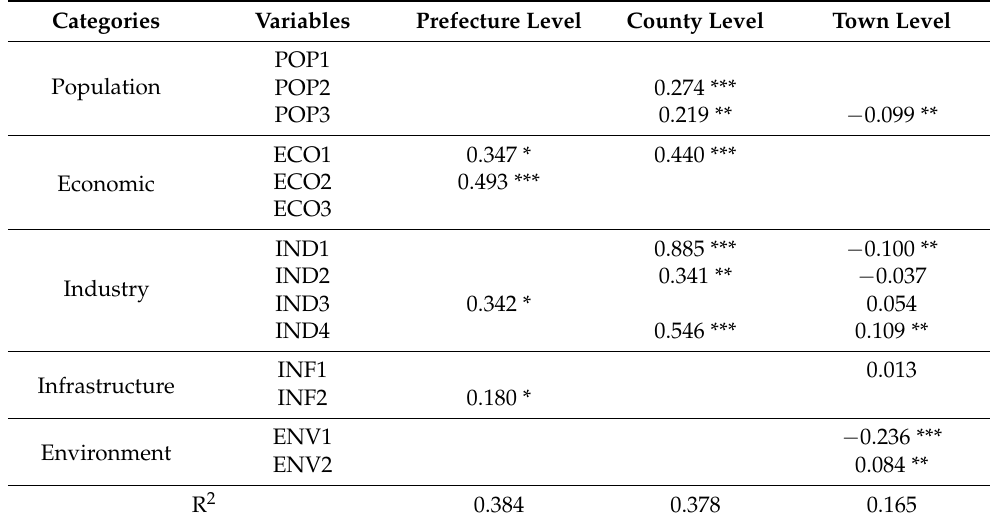
Table A1. The robustness tests of the OLS